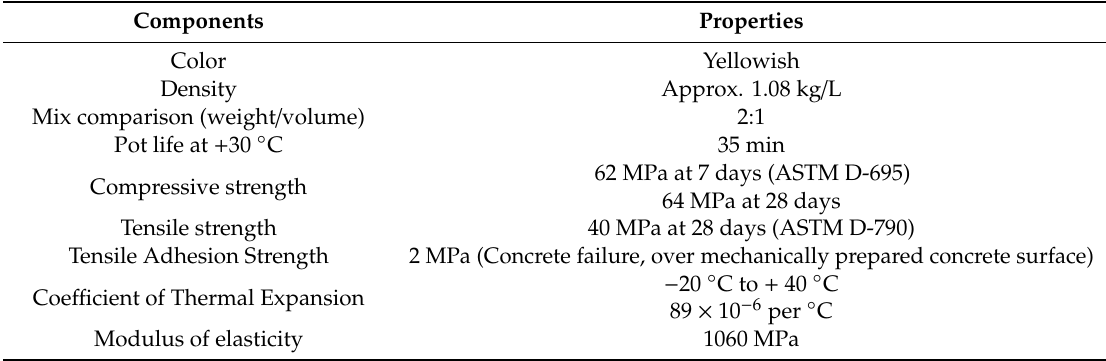
Table 2. The specification of Sikadur ® -752 [30].